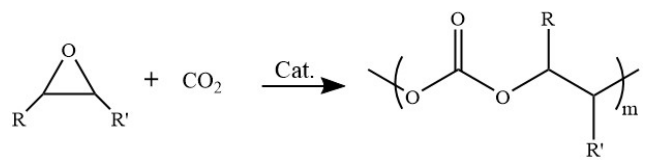
Figure 1. Copolymerization of CO 2 and epoxides.